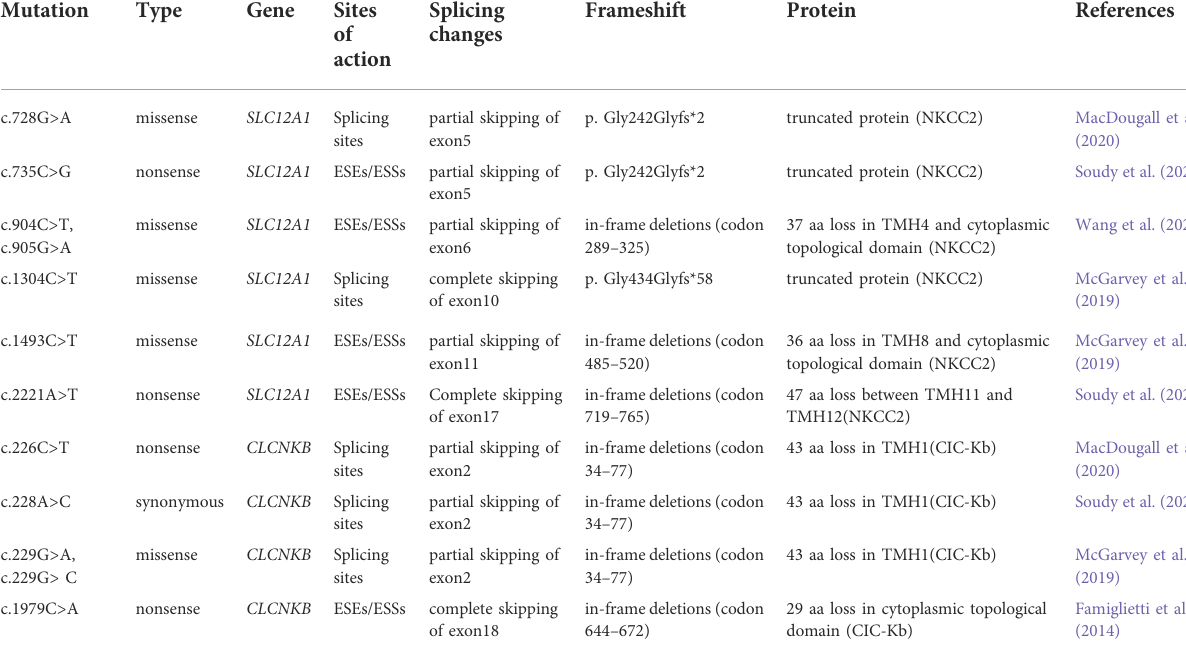
TABLE 3 Prediction of the functional consequences of exon skipping caused by point mutations in this